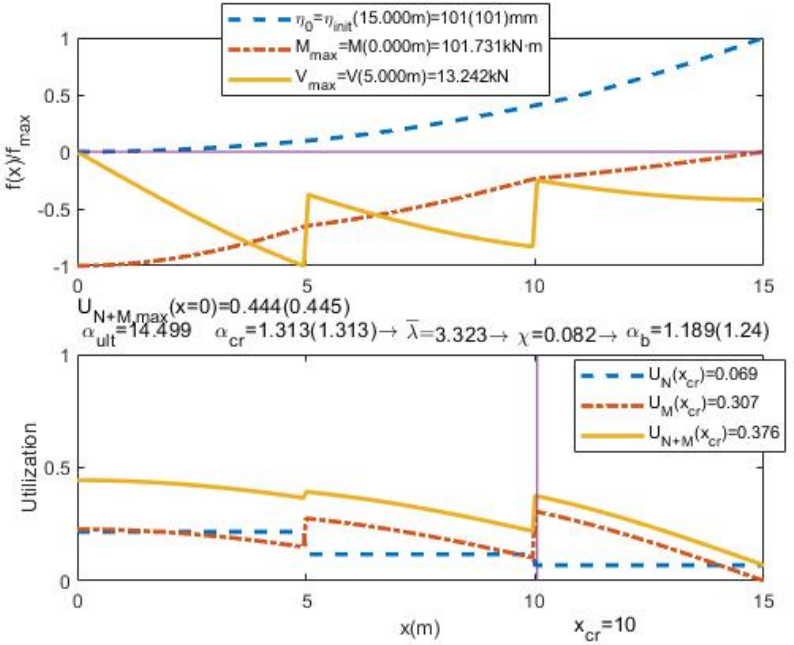
Figure 15. Example 5: UGLI imperfection η init , bending moment M , shear force V , and utilization factor.Values in brackets are taken from [24]. Value (1.24) was obtained by GMNIA.